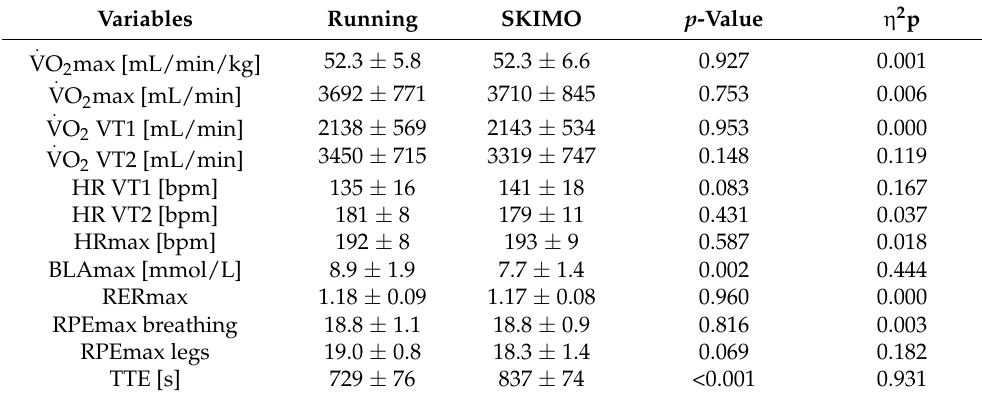
Table 4. Maximal and threshold values of the two exercise test protocols. Values are means ± SD. Variables Running SKIMO p -Value η 2 p . VO 2 max [mL/min/kg] 52.3 ± 5.8 52.3 ± 6.6 0.927 0.001 .